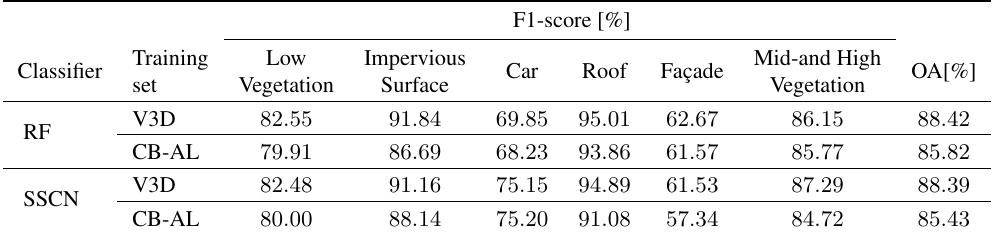
Table 3. Comparison of classification results on the test site of V3D when using the given V3D training dataset vs. using labels derived by our crowd-based AL